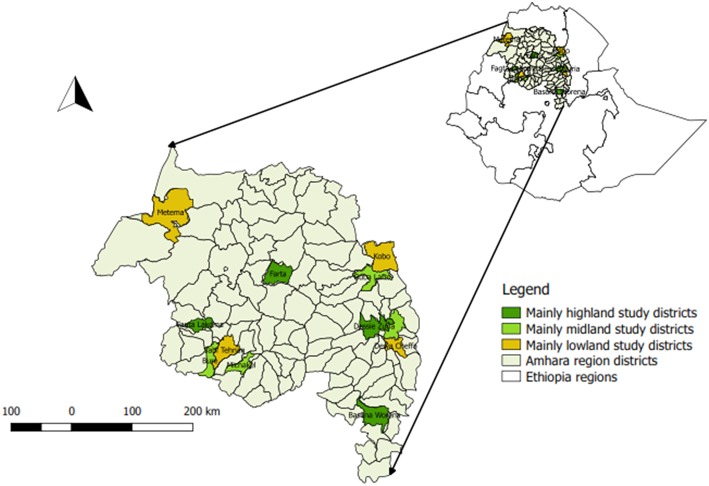
The map of Amahra region showing the study districts.